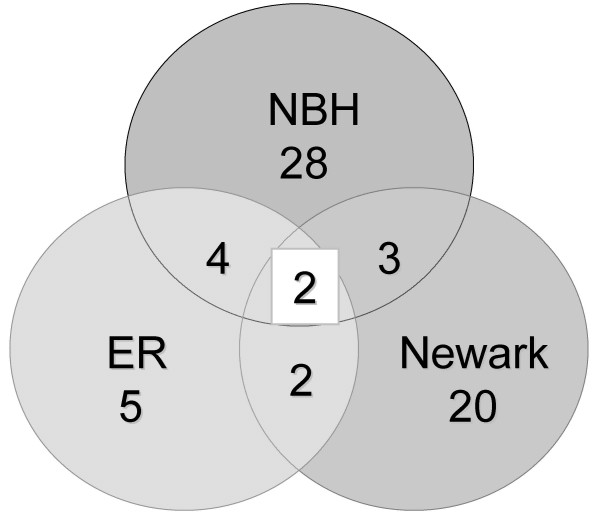
Venn Diagram showing numbers of significant genes (p < 0.01) for each polluted versus reference sites comparison. Two genes are significantly different in all three polluted populations compared to their respective reference populations. NBH = New Bedford Harbor comparison, Newark = Newark Bay comparison, ER = Elizabeth River comparison.